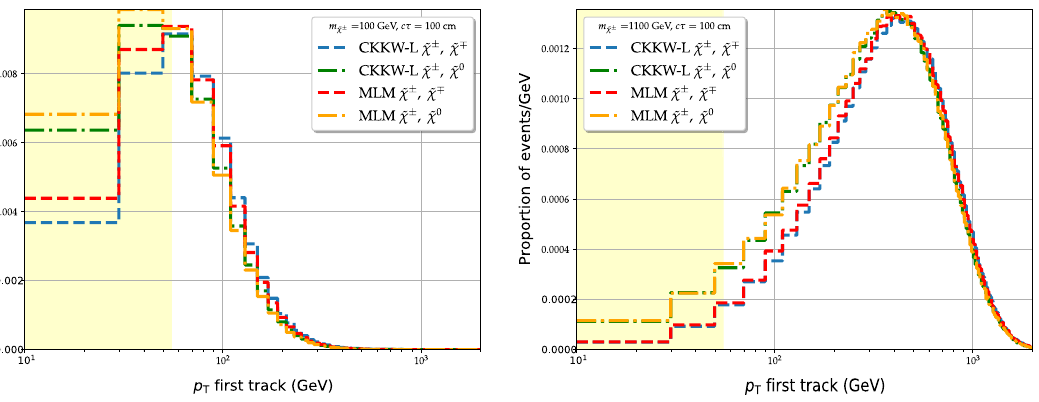
Fig. 3 Comparisonofthedistributionofhighest p T charginoperevent (labelledas p T firsttrackvsproportionofeventsperGeVineachbin)for double-chargino and single-chargino events, for both CKKW-L merg- ing and MLM matching. Left: 100 GeV winos; right: 1100 GeV winos.